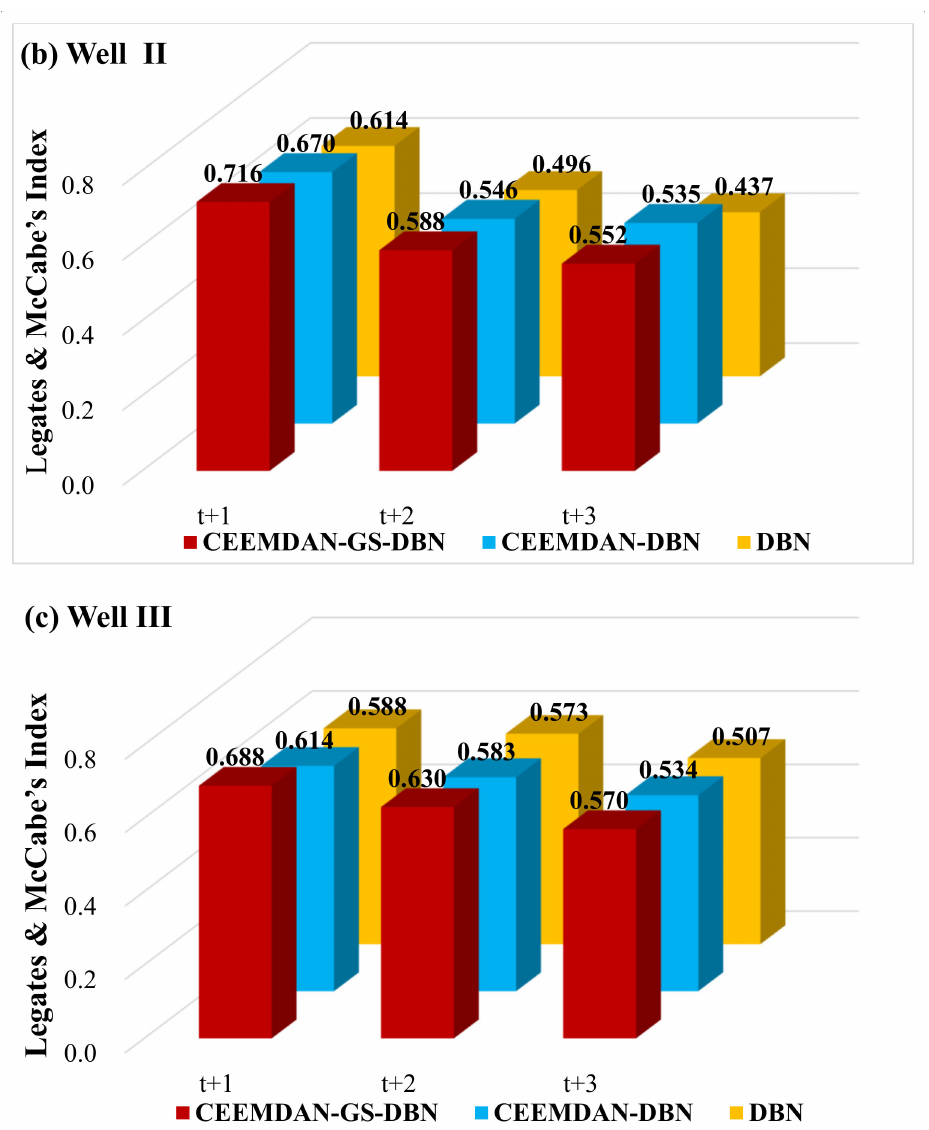
Figure 11. The Legates and McCabe’s Index in testing phase of the hybrid CEEMDAN-GA-DBN vs. CEEMDAN-DBN and DBN models for ( a ) Well I, ( b ) Well II and ( c ) Well